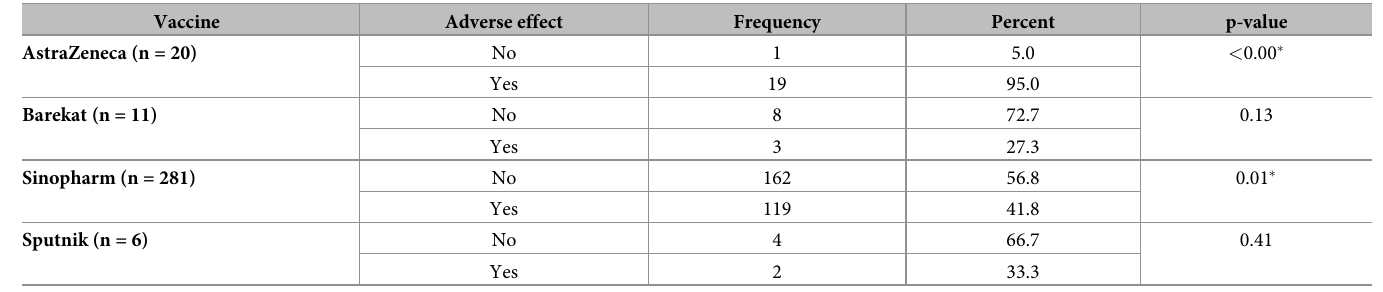
Table 5. Type of vaccine and adverse effect of vaccine in each group.